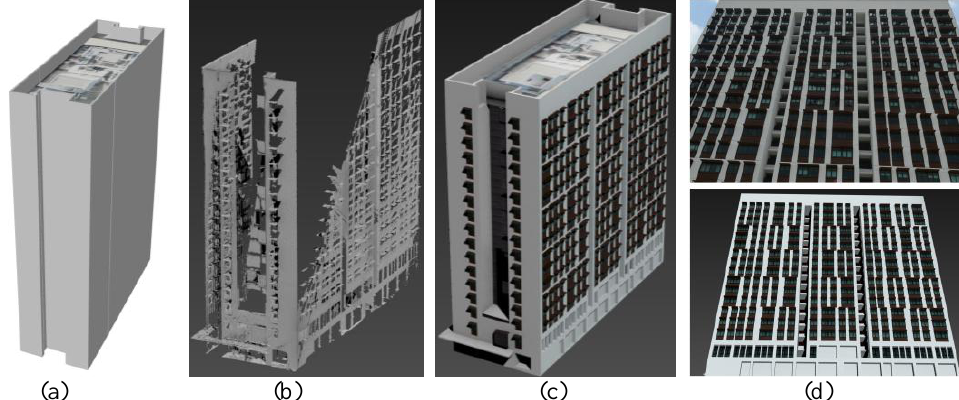
Figure 6: Example of a complete building model, (a) roof model from UAV images, (b) wrapped mesh from MMS point clouds, (c) complete model by integrating roofs and façades, (d) façade image (up) and 3D model